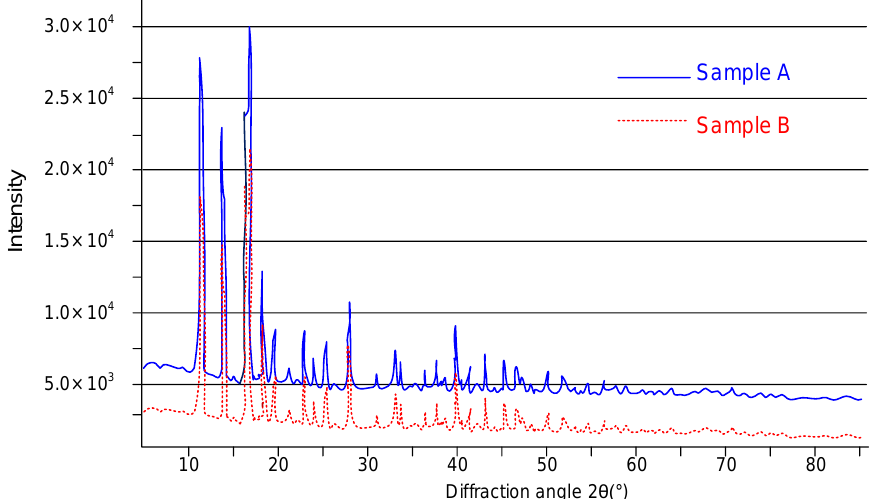
Figure 2. Comparison between X-ray diffraction spectra of two samples of iron citrate powder. Samples A and B are two independent replicates.